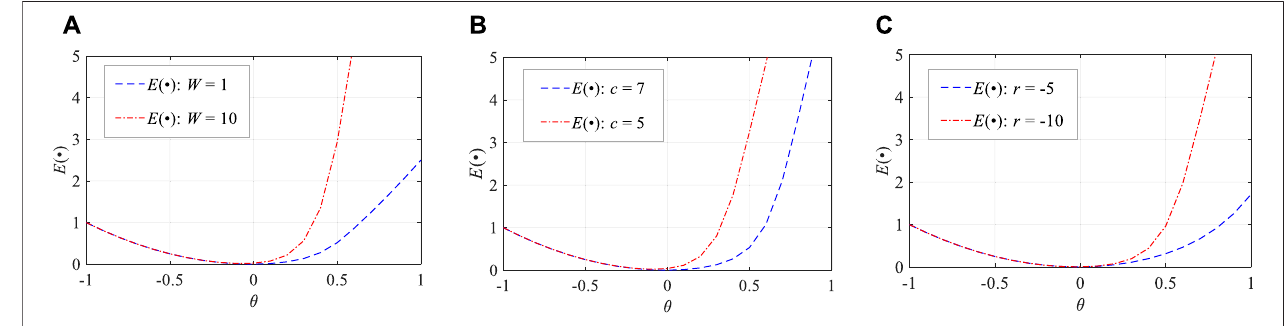
FIGURE 3 | Illustration of the hyper-parameters of E ( · ): (A) change on the value of W , (B) change on the value of c , and (C) change on the value of r